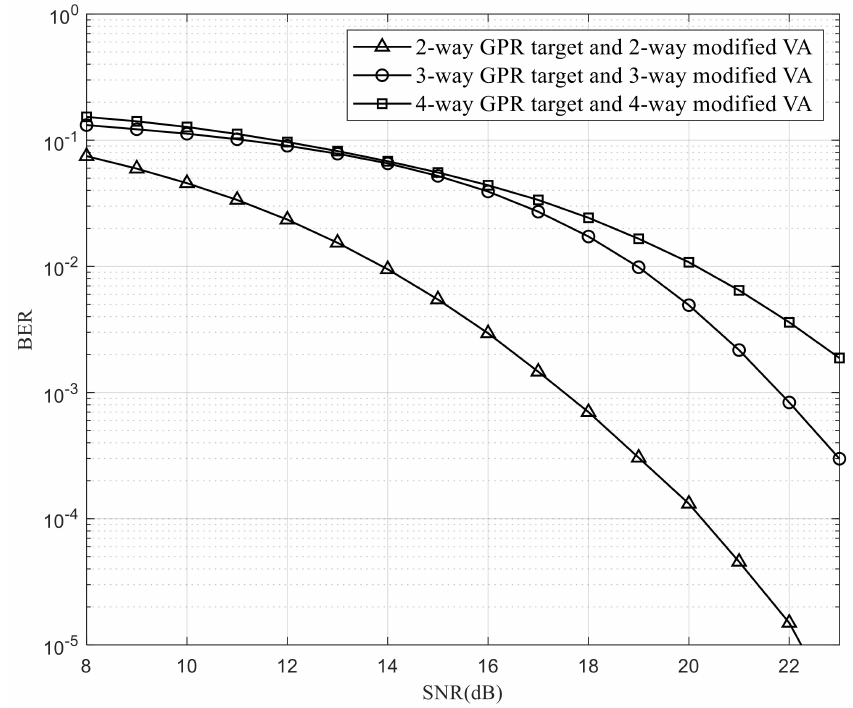
Figure 10. Combined N-way generalized partial response (GPR) target and N-way MVA.